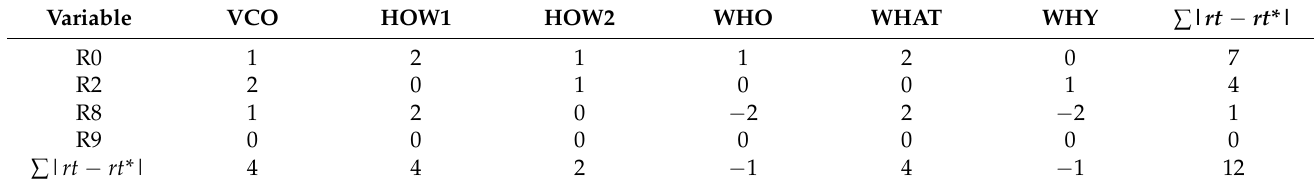
Table 8. | rt − rt* | (values from Table 6 minus values from Table 7). Variable